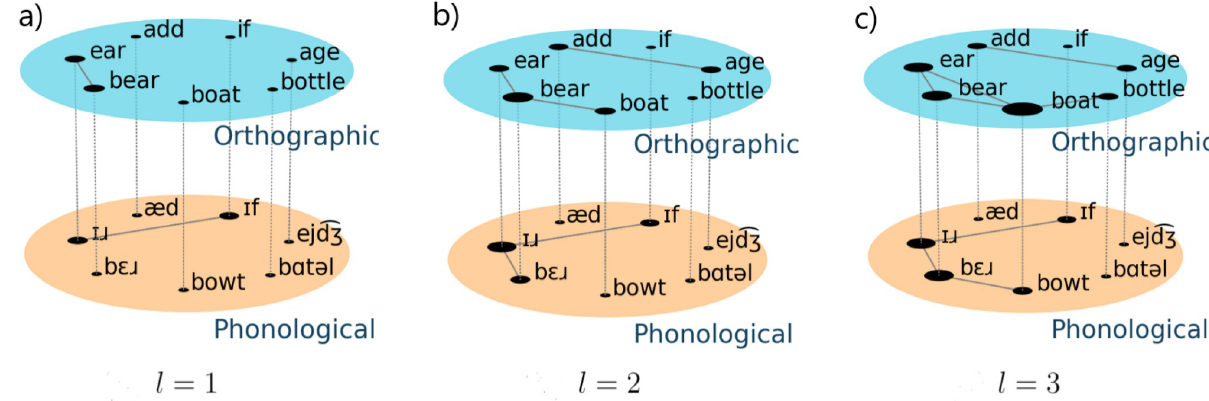
Fig 1. Construction of the multiplex language network. Representative multiplex network for English language and several distance thresholds. Each layer represents the orthographic (top) and phonological (bottom) networks. Here, nodes are words and there is a link if the Damerau-Levenshtein distance is smaller than a given threshold (a) ℓ = 1, (b) ℓ = 2 and (c) ℓ = 3. Notice that words in the phonological layer were translated into the International Phonetic Alphabet and then the DL was calculated. The figures where generated by using the free python library pymnet [45, 46].